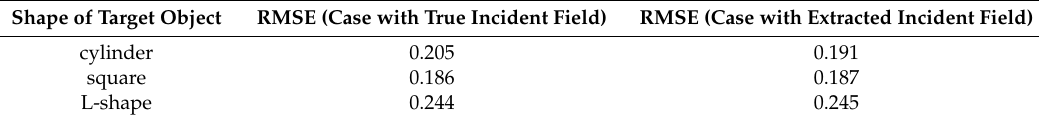
Table 1. Reconstruction errors.